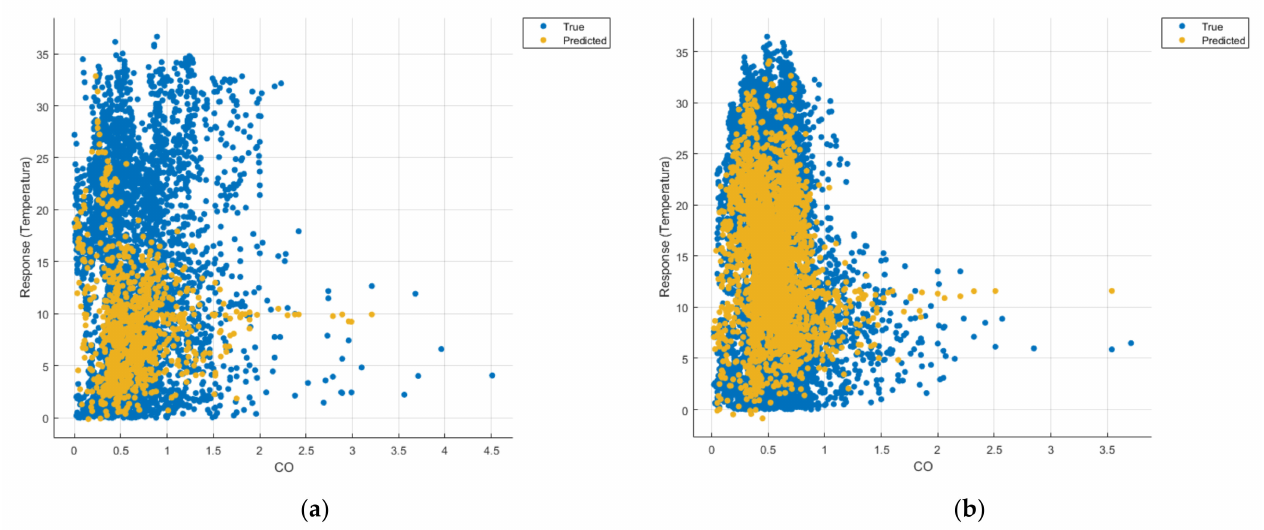
Figure 16. Prediction considering only CO 2 –Fine Gaussian SVM. ( a ) March 2019—February 2020, ( b ) March 2020– February 2021.